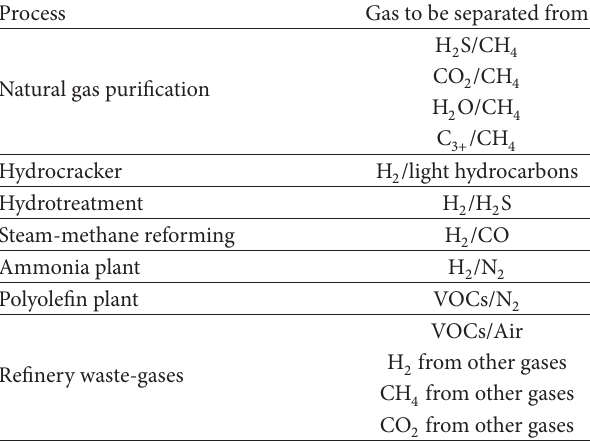
Table 1: Processes where membrane technology is implemented [25–27].